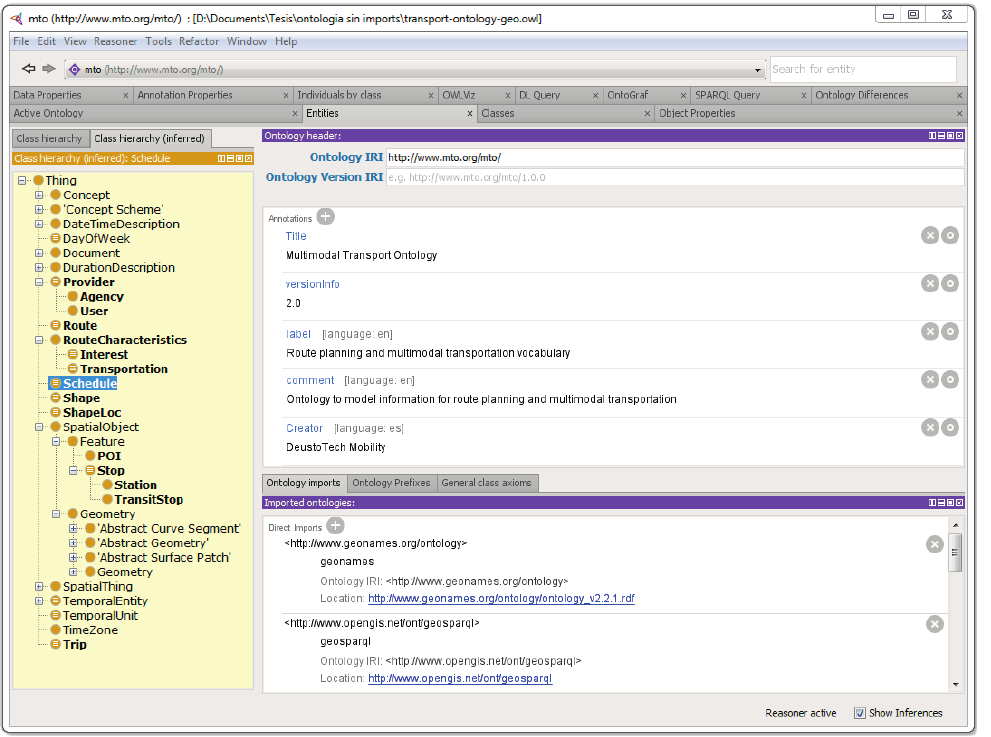
Figure 2. MTO OWL file in